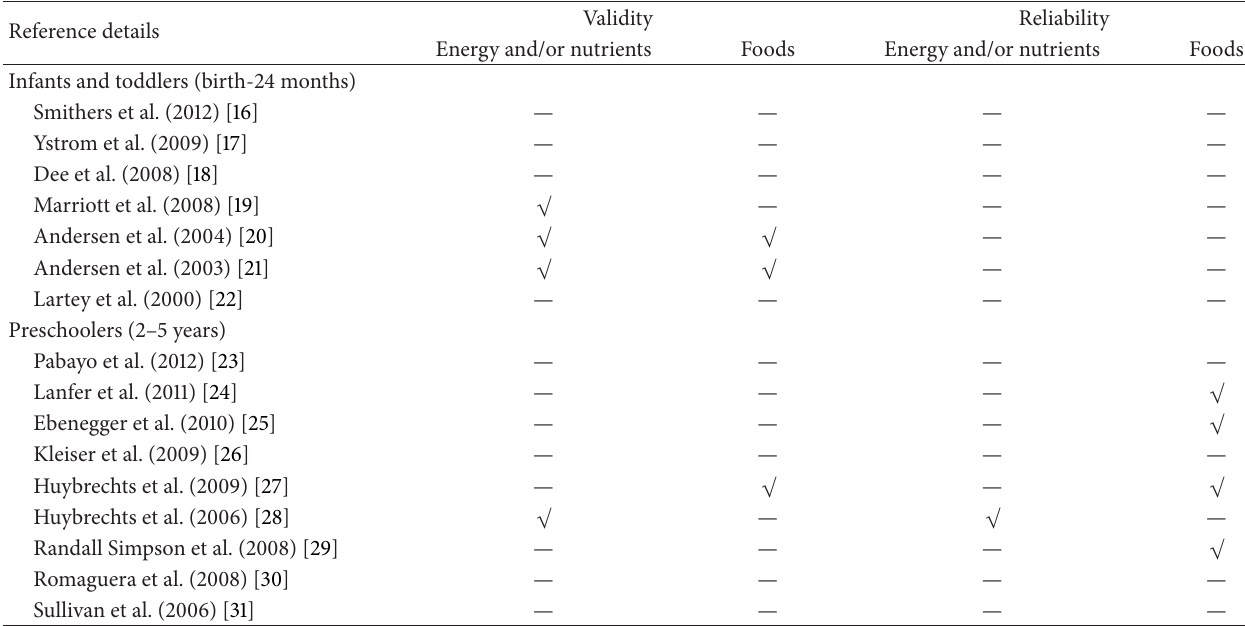
Table 2: Summary of availability of validity and reproducibility data for each study according to energy and/or nutrient intake and food